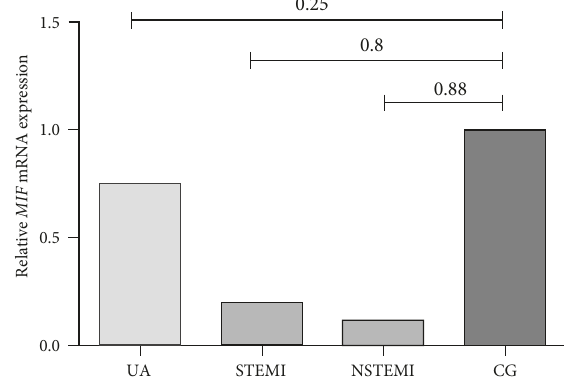
Figure 1: Relative MIF mRNA expression of total leucocytes in the clinical manifestation of ACS and CG. STEMI and NSTEMI samples showed 0.8 and 0.88, respectively, less MIF mRNA ex- pression compared with CG.